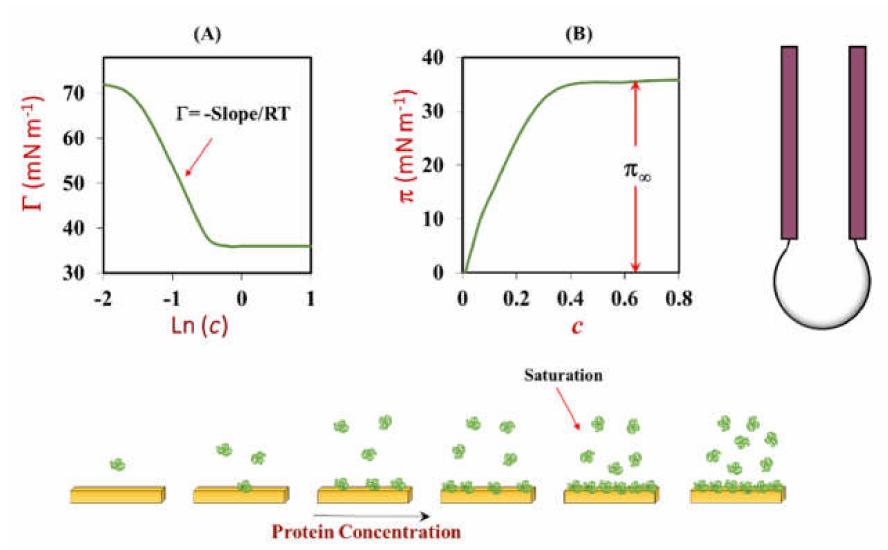
Figure 16. The interfacial properties of a protein-based emulsifier can be characterized by measuring the interfacial tension versus protein concentration profile. The surface pressure versus concentration can then be calculated from this data. The data ( A , B ) shown are just schematic representations.